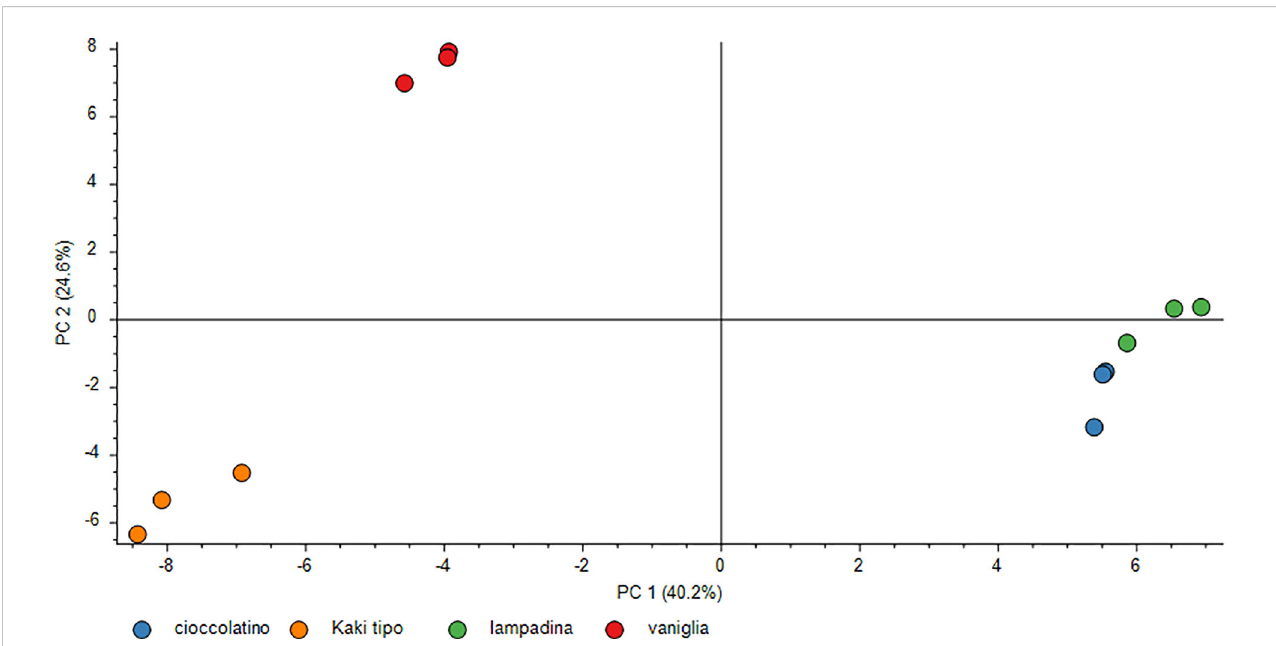
FIGURE 5 PCA score plot of differentially represented proteins in persimmon fruits of Kaki tipo, Cioccolatino, Vaniglia and Lampadina cultivars. This plot demonstrates the separation of the protein level data (normalized abundances) and the genotype dependent relationship. Each point in the chart describes a biological replicate. PCA explained about 64.8% of variability among persimmon